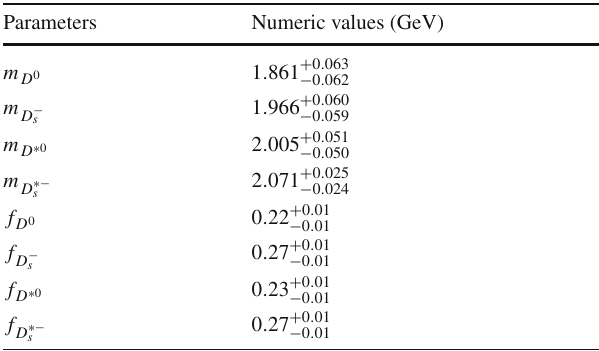
Table 2 Obtained mass and coupling constant values of D mesons at T = 0 produced in the decays of tetraquark Z cs Parameters